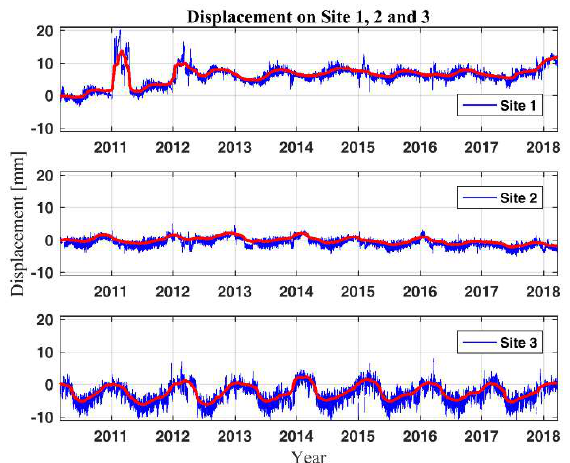
Figure 14. Time–Displacement diagram for the three sites during 8 years of monitoring. Note that negative values indicate shorter distance between the radar and the reflectors. The blue line is the raw-data, while the red line is the 3-months moving mean. The figure shows annual cyclic variations, which correlate with the annual temperature variations.